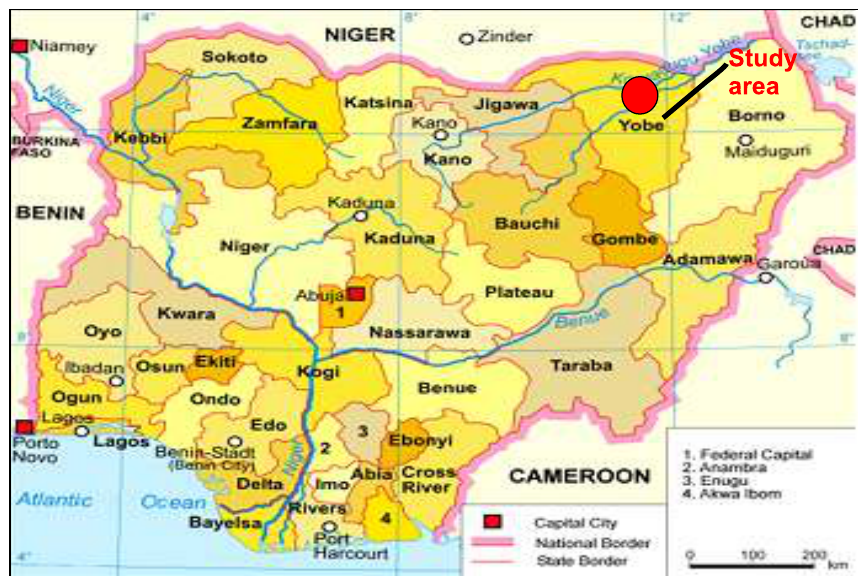
Figure-1. Map of Nigeria showing the Yobe State (study Niger Republic which enhances trans-border move- odds ratio (OR) for comparison and determination of ment of livestock between the two countries.